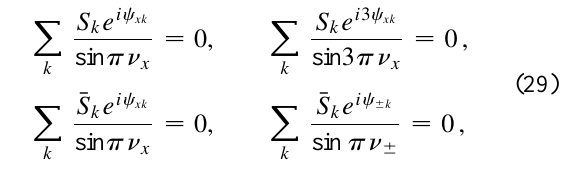
roughly constant despite various versions and correction